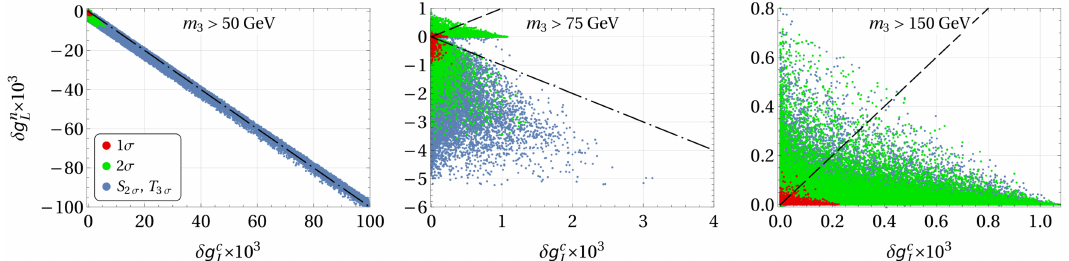
in the aligned 2HDM. The displayed points and the colour versus δg c L L = − δg c . Notice the vastly different scales in the L L